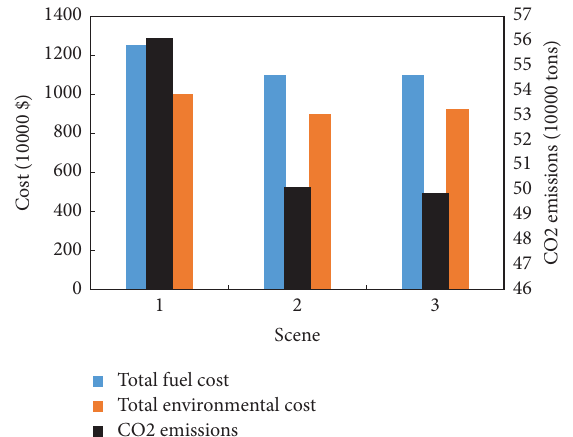
Figure 3: Economic metrics and system CO ferent scenarios.